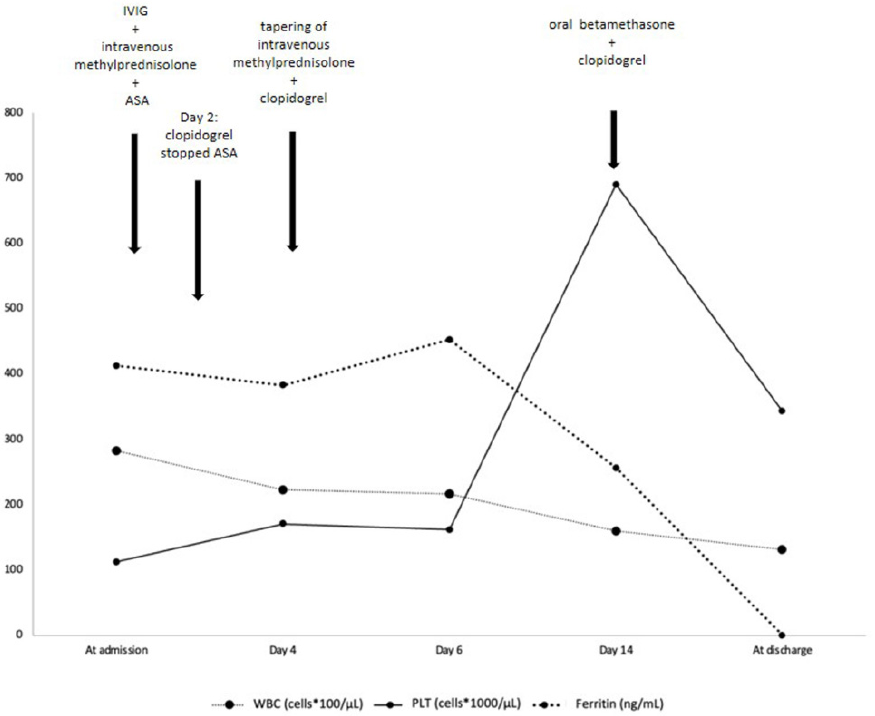
Figure 2. Timeline evolution of most relevant laboratory findings and treatment. IVIG = intravenous immunoglobulin; ASA = acetylsalicylic acid; WBC= white blood cells; PLT = platelets. Ferritin (ng/mL) reference value < 320.